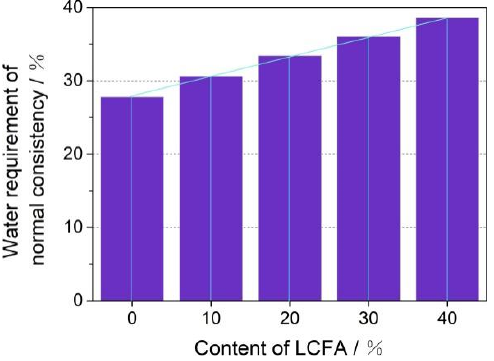
Figure 4. Water requirement of normal consistency of different admixtures of LCFA.